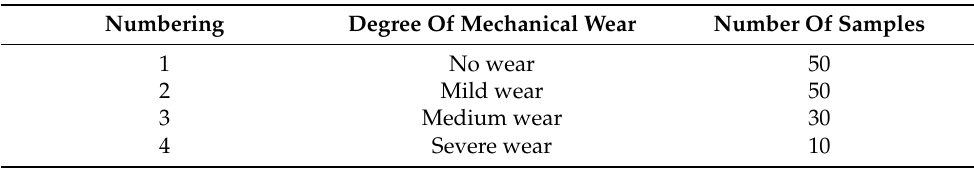
Table 1. Data of mechanical wear